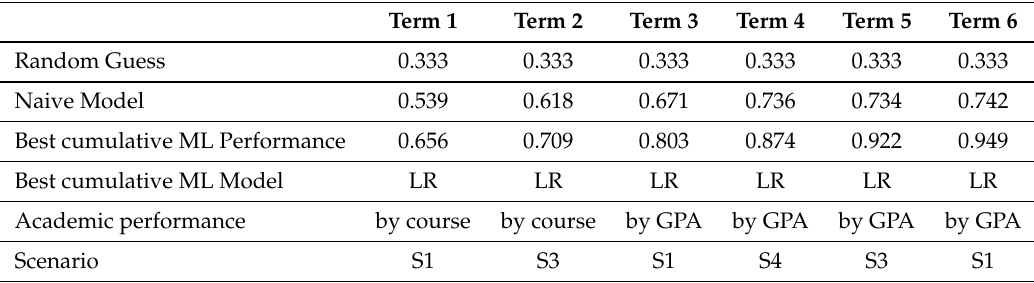
Table 10. Summary of the best models per